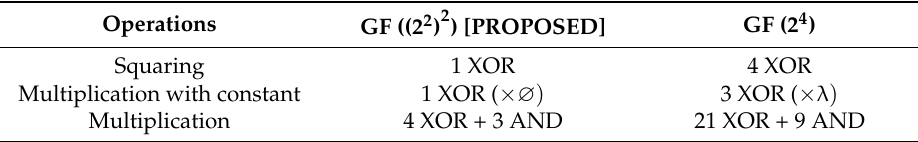
Table 3. Individual gate counts of the substructures in GF (( 2 2 ) 2 ) and GF ( 2 4 ) .